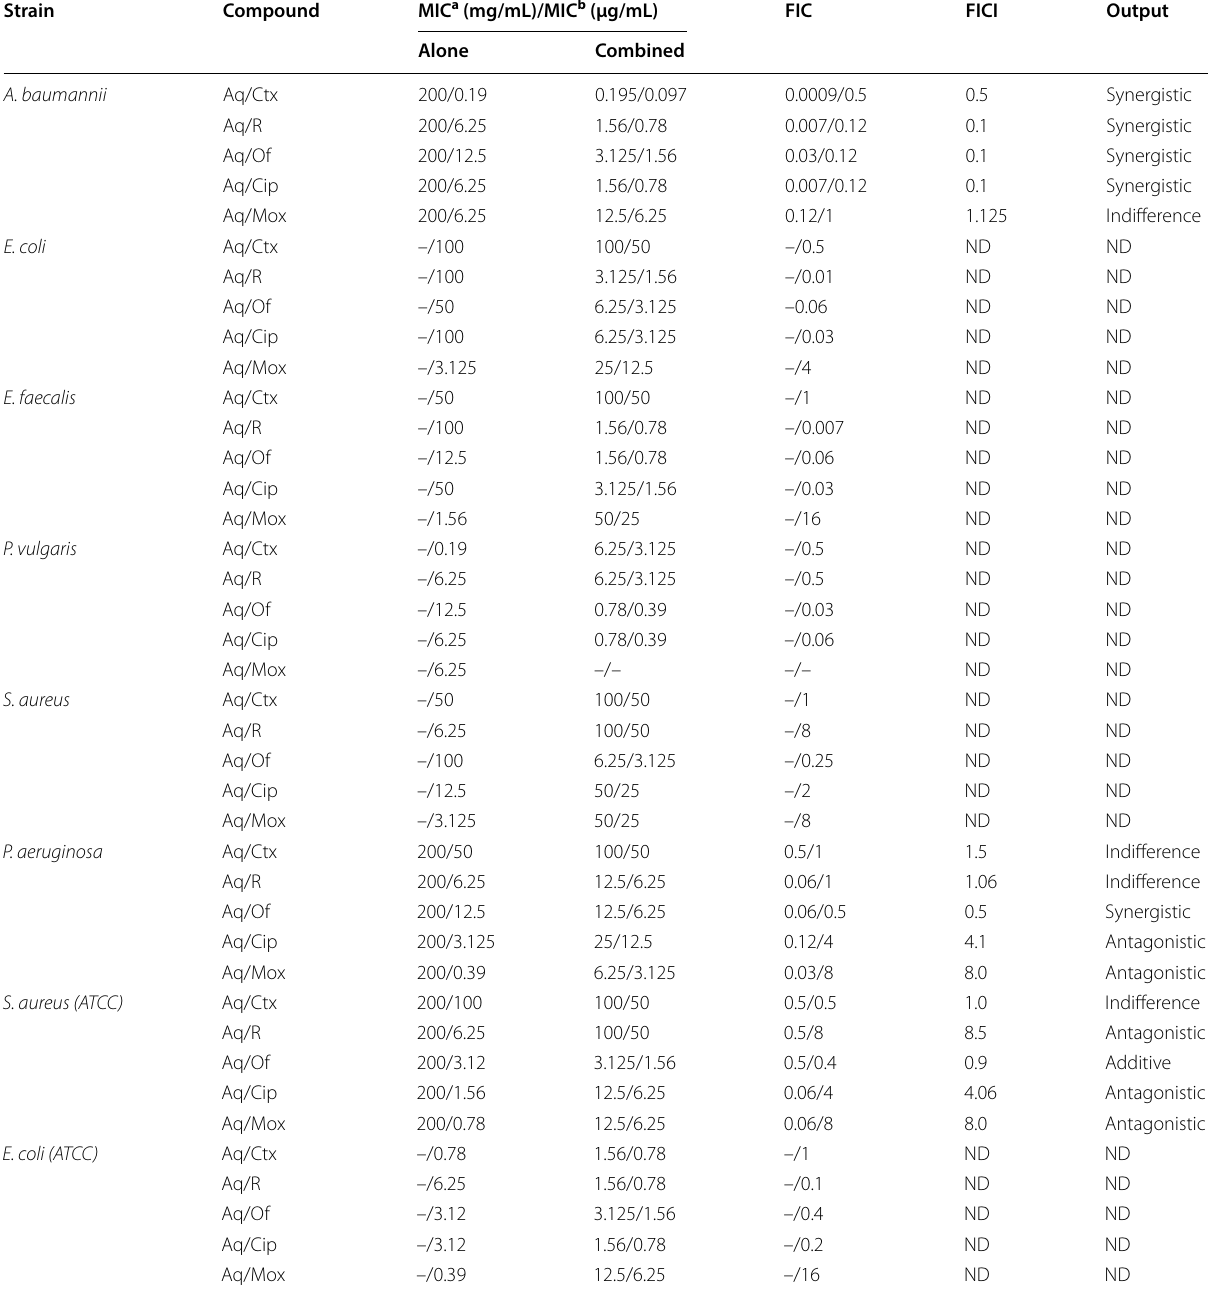
MIC a minimal inhibitory concentration for aqueous extract when applied alone, MIC b minimal inhibitory concentration for antibiotic when applied alone, Me methanolic extract, Ctx cefotaxime, R rifampicin, Of ofloxacin, Cip ciprofloxacin, Mox moxifloxacin, ND not determined